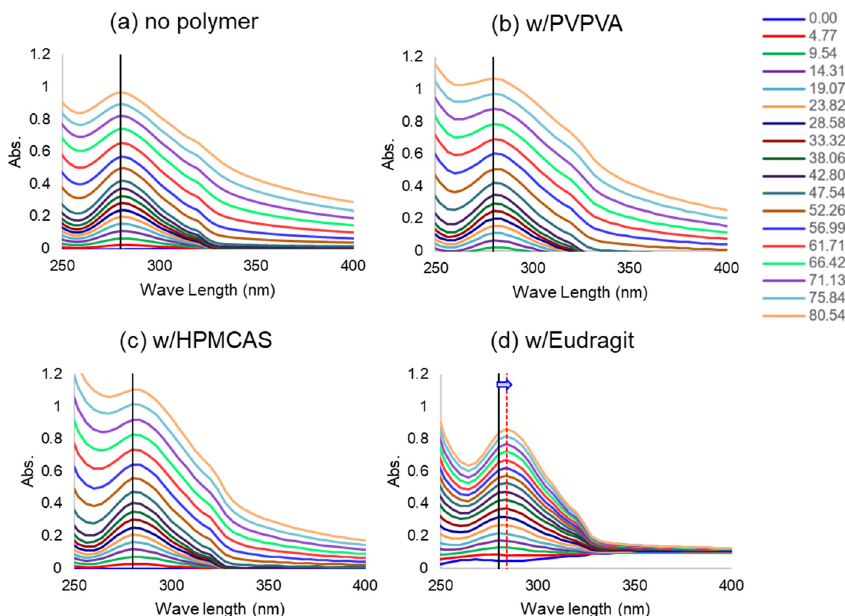
Figure 4. Effect of coexisting polymers on the UV spectra of NFT. The NFT concentrations ( µ g/mL) are shown in the figure (the concentration increased from bottom to top). The absorption maximum and its shift in the presence of Eudragit are presented by vertical lines in the figure.